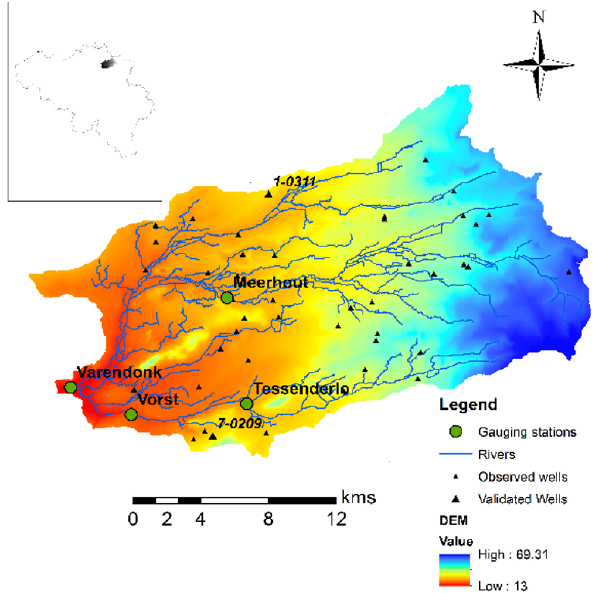
Figure 2. The Grote Nete catchment with the internal flow stations at Meerhout, Vorst and Tessenderlo, and the outlet station at Varen-